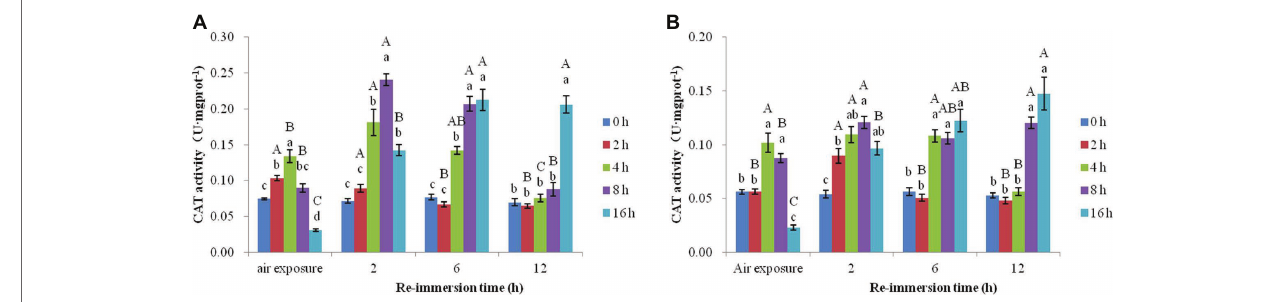
FIGURE 5 | Effects of air exposure and reimmersion on catalase (CAT) in the gills (A) and hepatopancreas (B) of Chinese mitten crab. Different lowercase letters represent a significant difference between the different air exposure times at the same reimmersion time ( p < 0.05). Different uppercase letters represent a significant difference between the different reimmersion times at the same air exposure time ( p <